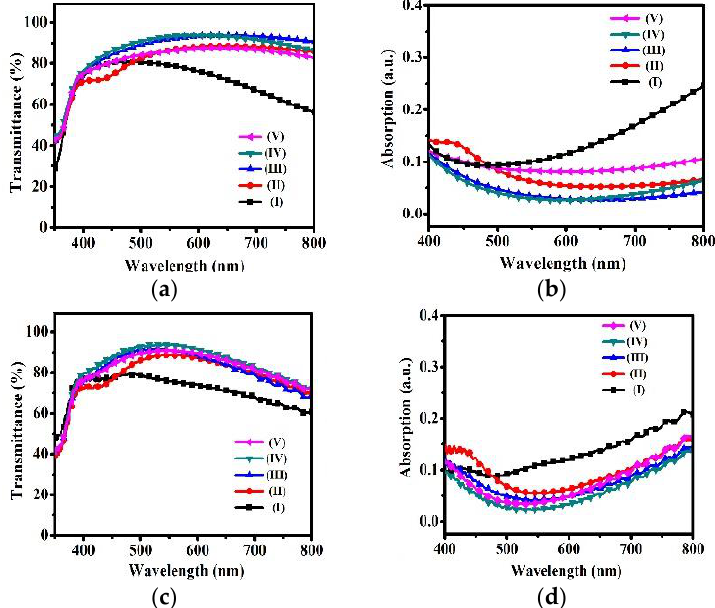
Figure 5. Properties of ZnO/Ag/ZnO multilayer films for different f(O 2 ) from 0% to 4.0% on glass: ( a ) optical transmittance spectra; and ( b ) absorption spectra; Properties of ZnO/Ag/ZnO multilayer films for different f(O 2 ) from 0% to 4.0% on PET: ( c ) optical transmittance spectra; ( d ) absorption spectra.